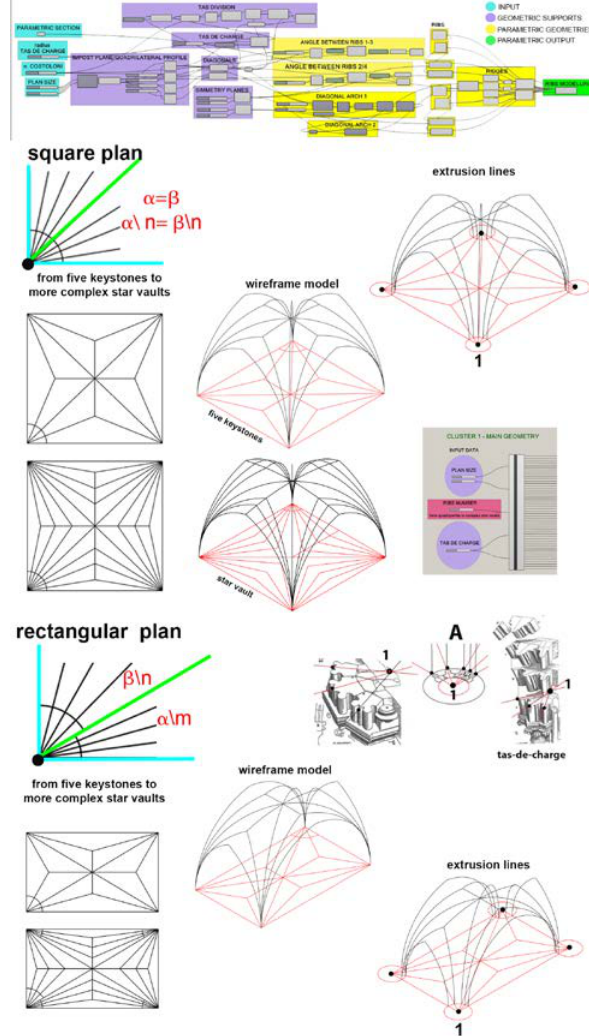
Figure 9. Workflow for parametric model definition. From square to rectangular plan and from five keystones vault to more complex star